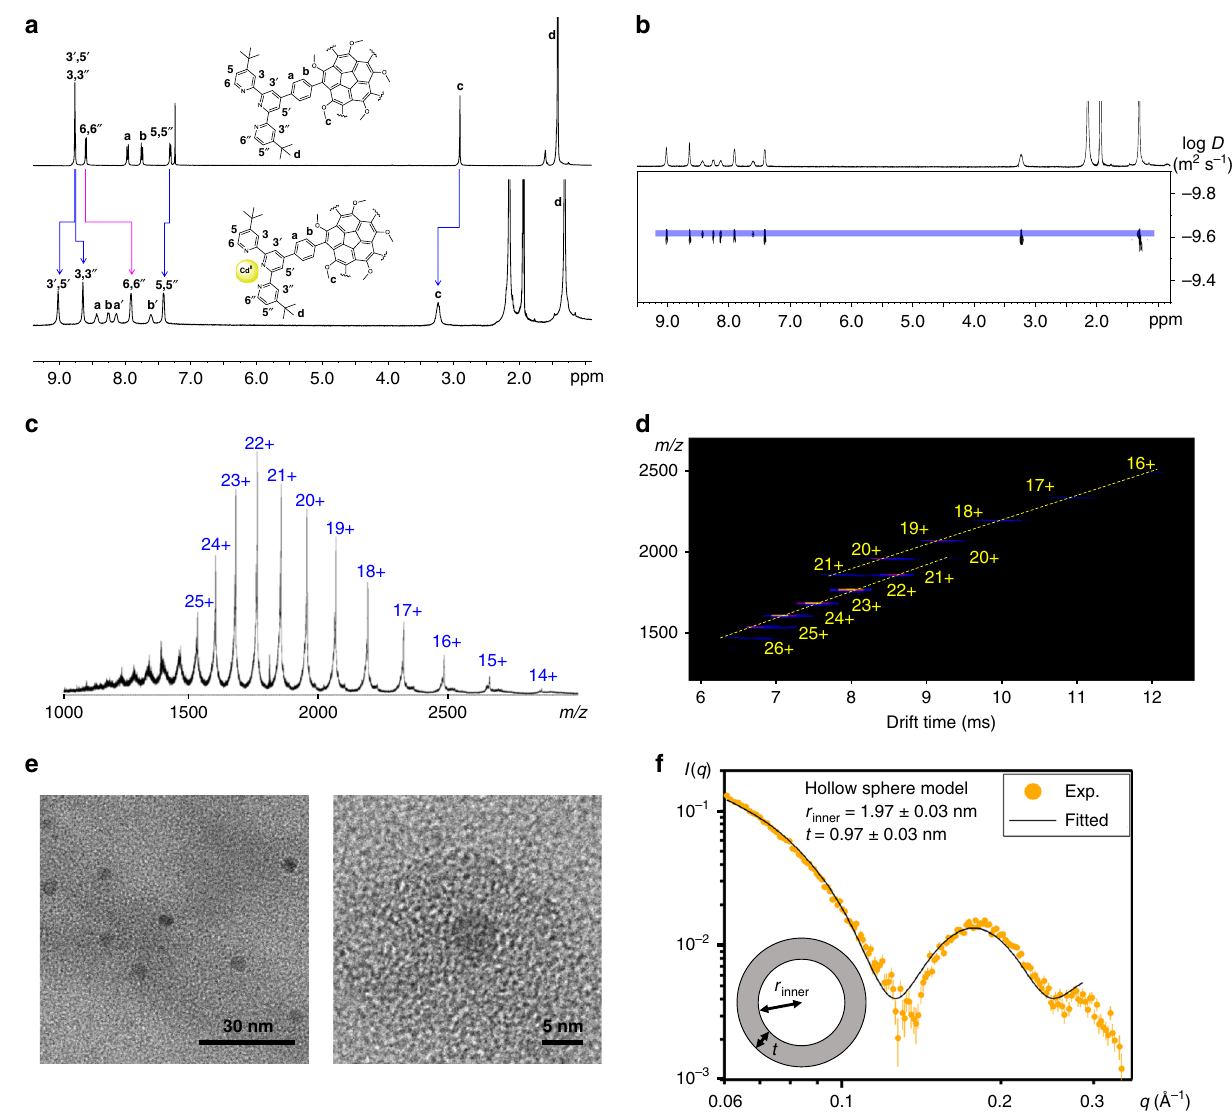
Fig. 3 Structural characterization of self-assembled 4b . a 1 H NMR spectra of ligand 3b in CDCl 3 (top) and 4b in CD 3 CN (bottom). b DOSY NMR spectrum of 4b in CD 3 CN at 25 ˚ C. c ESI-MS spectrum. d ESI-TWIM-MS plot. e TEM micrographs of the samples prepared by drop casting a dilute solution of 4b (10 − 6 ~10 − 7 M) in acetonitrile onto a carbon-coated copper grid. f SAXS pro fi le of 4b (0.5 mg mL − 1 in acetonitrile) and the fi tting result derived from the hollow sphere model. The error bars represent the uncertainties in the scattering